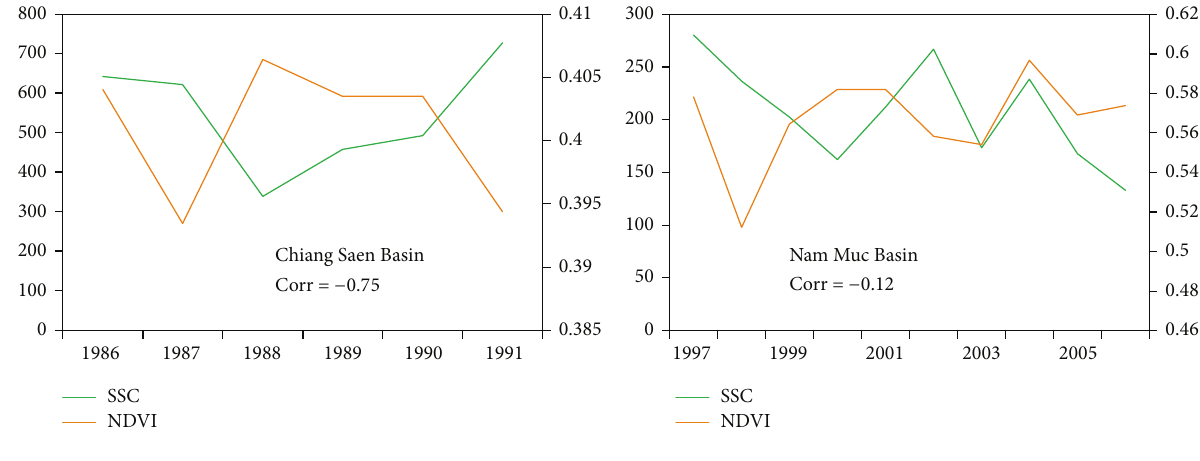
Figure 8: Relationship between annual SSC and NDVI (Corr: correlation coefficient). Table 5: Comparison of simulation results from new sediment rating curve and common sediment rating curve in Chiang Saen Basin.